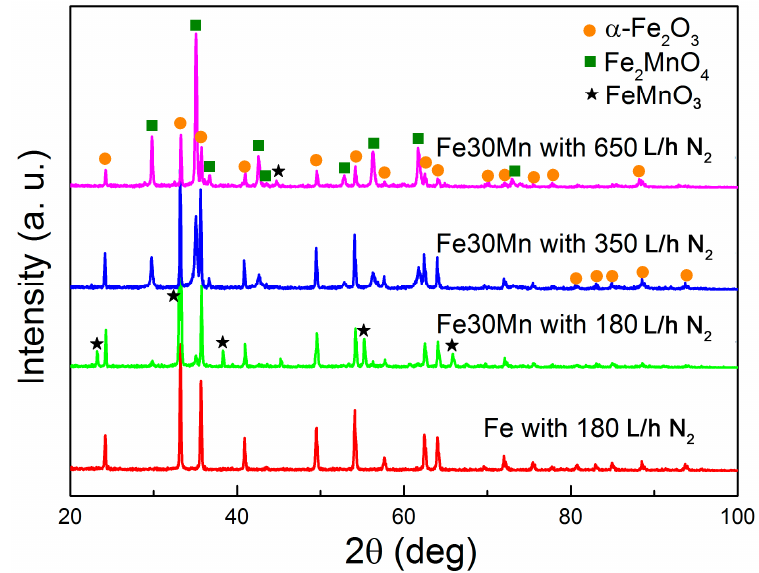
Figure 2. X-ray diffraction (XRD) patterns of the Fe-O foam produced at N 2 flow of 180 L/h and Fe-Mn-O foams produced at a N 2 flow of 180 L/h, 350 L/h and 650 L/h.